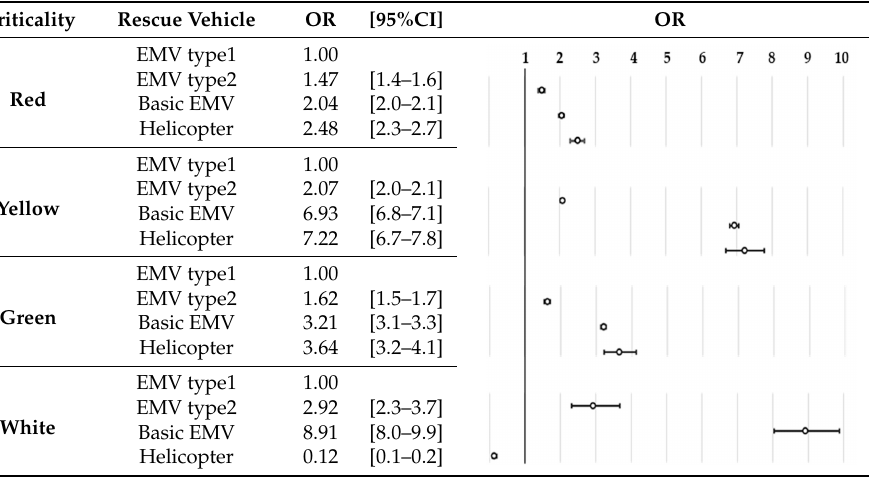
Table 3. Adjusted Odds Ratios and 95% confidence interval (95%CI) of rescue completion in a hospital Emergency Department (ED) by type of rescue vehicle and Emergency Medical Services (EMS) criticality codes; Piedmont 2013–2017.